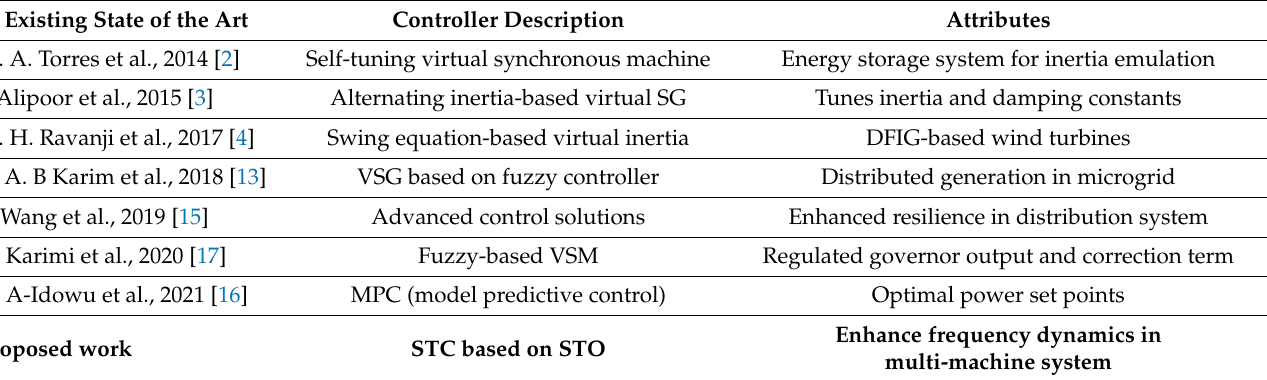
Table 1. Comparison of current work eminence and state of the